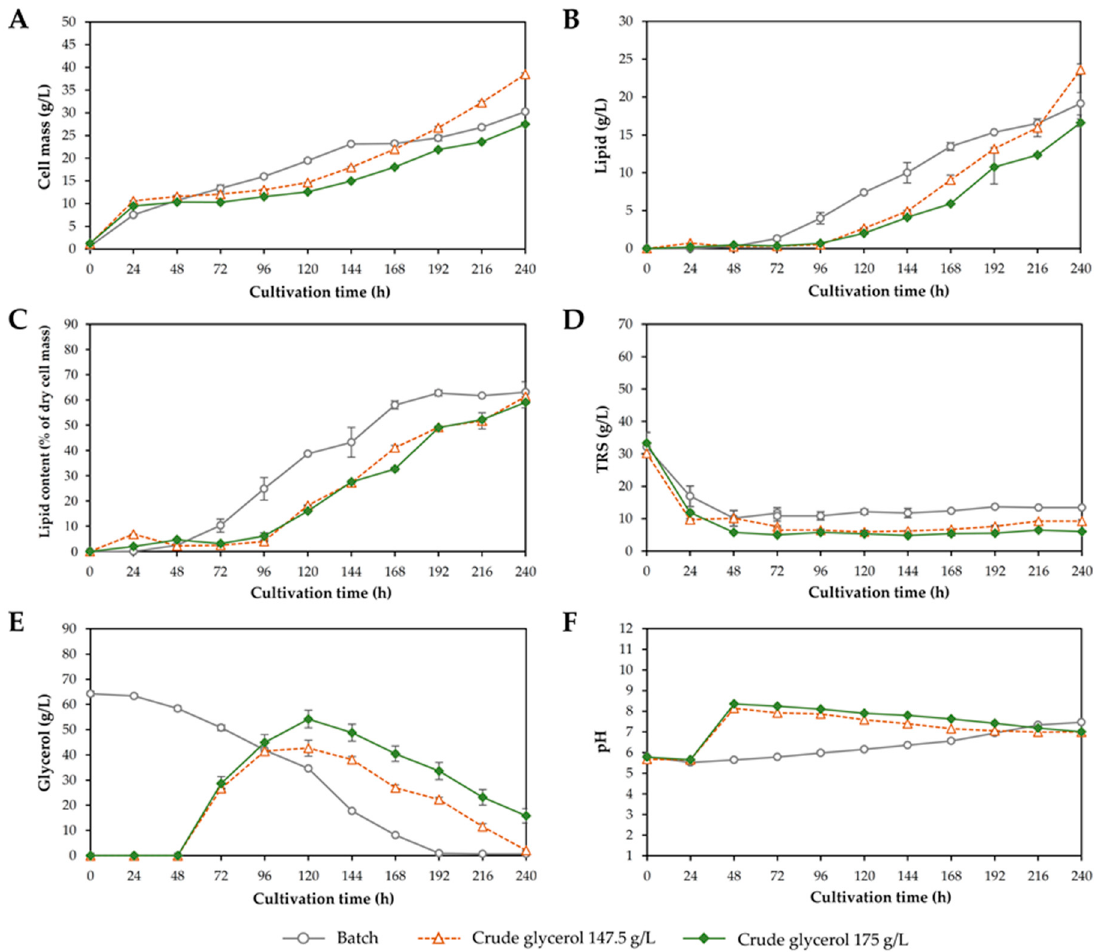
Figure 6. Lipid production by Rhodosporidiobolus fluvialis DMKU-SP314 in a 3 L stirred-tank fermenter using batch cultivation and two-stage fed-batch cultivation with constant feeding of different concentrations of crude glycerol solution of 147.5 and 175 g/L at the dilution rate of 0.012 h − 1 after 48 h of batch cultivation. ( A ) Cell mass, ( B ) lipid, ( C ) lipid content, ( D ) total reducing sugars (TRS), ( E ) glycerol, and ( F ) pH.